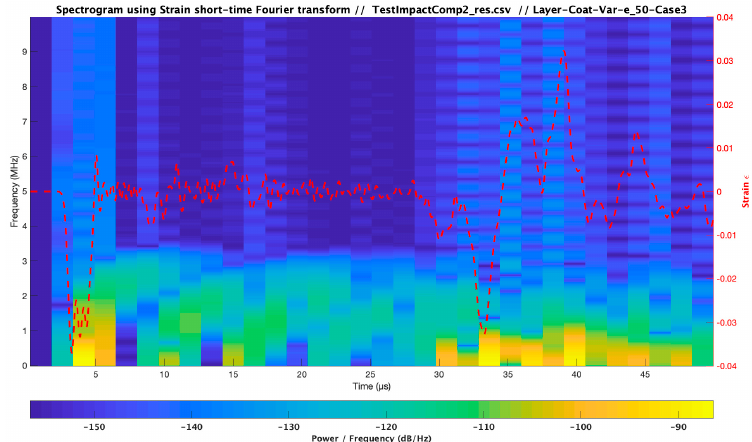
Figure 27. Spectrogram for strain evolution at the middle coating layer, 50% thickness, considering substrate-filler as semi-infinite with increased thickness (shells, tapes). Case 3.